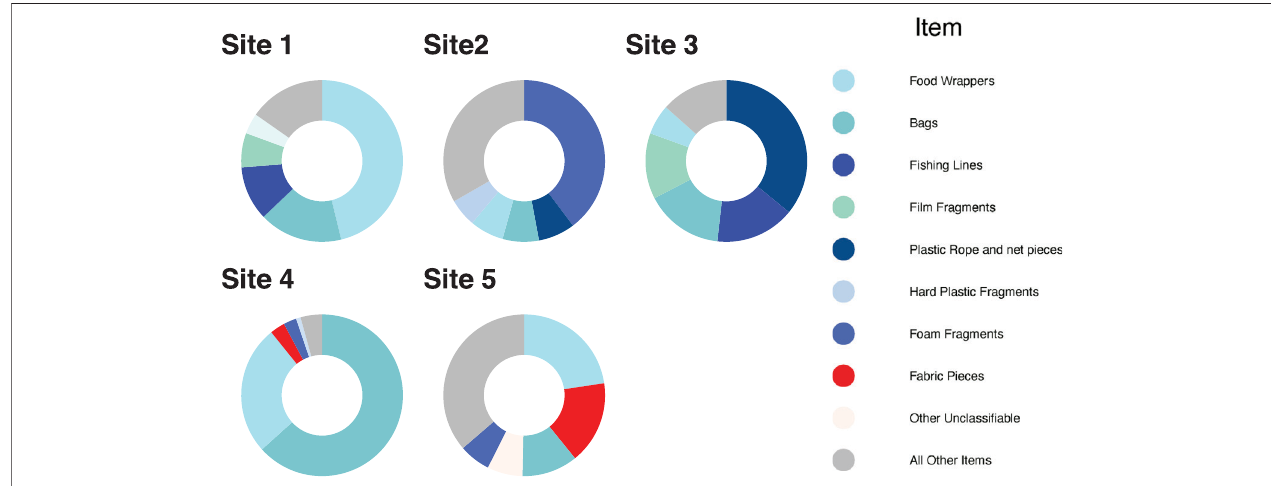
FIGURE 3 | Top fi ve debris items found in each site. The types of debris are characterized by color and the legend shows which color matches which debris item (right). Plastic items shown in shades of blue represent the majority of the top fi ve items.